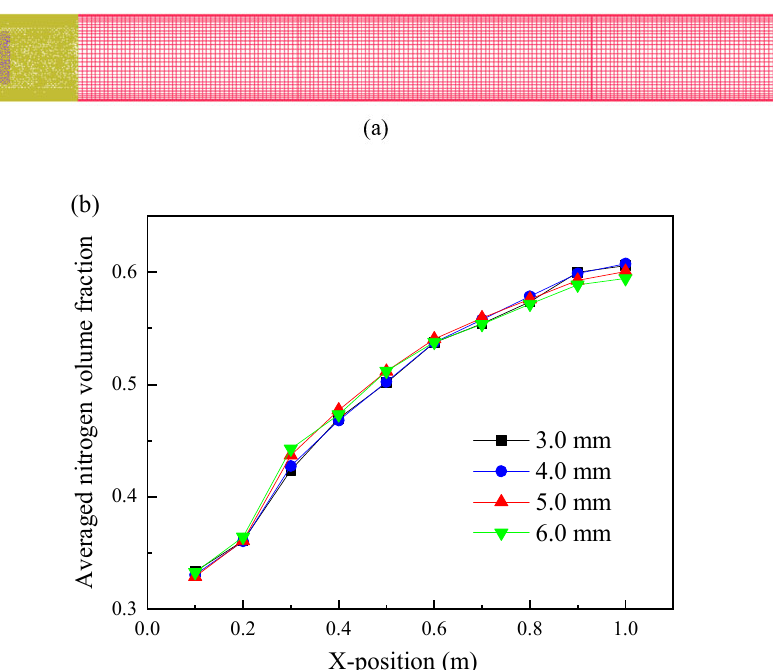
Figure 1. The schematic diagram of meshing (a) and the results of mesh independence (b).2.6. Model Validation.